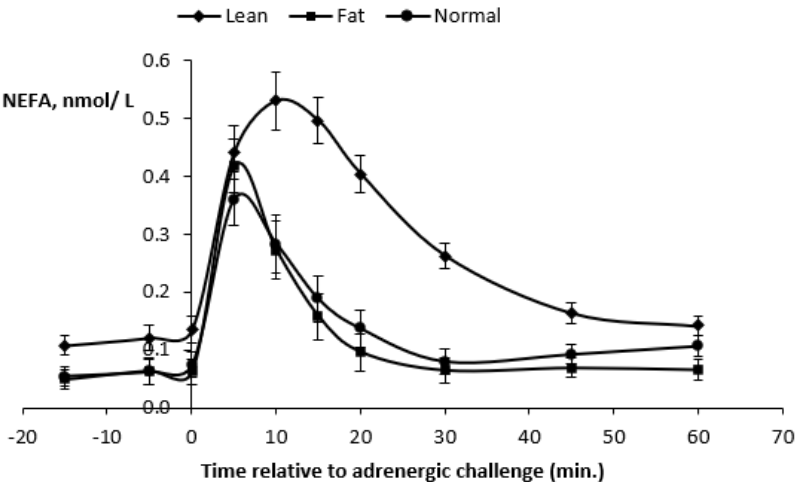
Figure 5. E ff ects of the β -adrenergic challenge injection with isoproterenol (ISO, 4 nmol / kg BW) on plasma nonesterified (NEFA) or free fatty acids (FFA) kinetics of mature, dry, nonpregnant Merinos d’Arles ewes ( n = 36) with low (underfed or lean ewes), medium (control or normal ewes) and high (overfed or fat ewes) body condition scores. Bars are SEM.